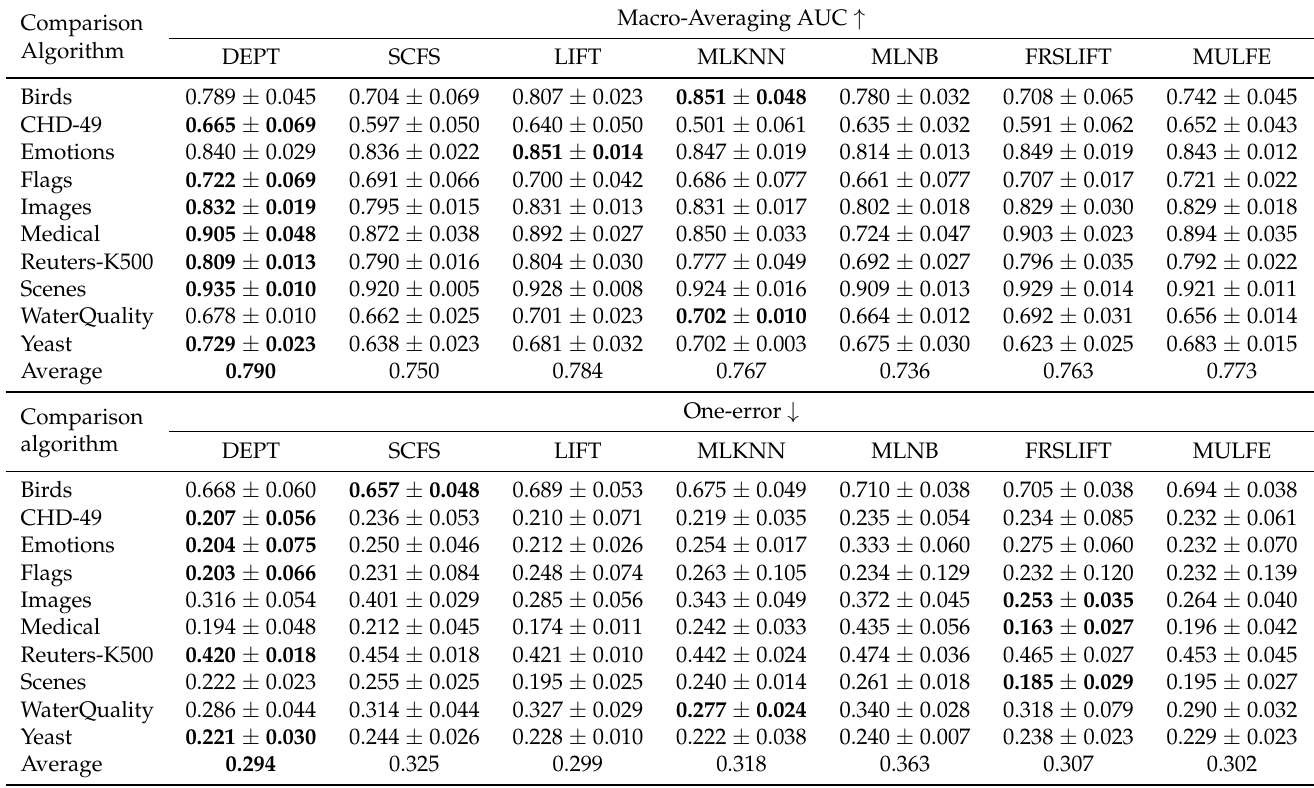
Table 3. Experimental results of each comparison algorithm (mean ±